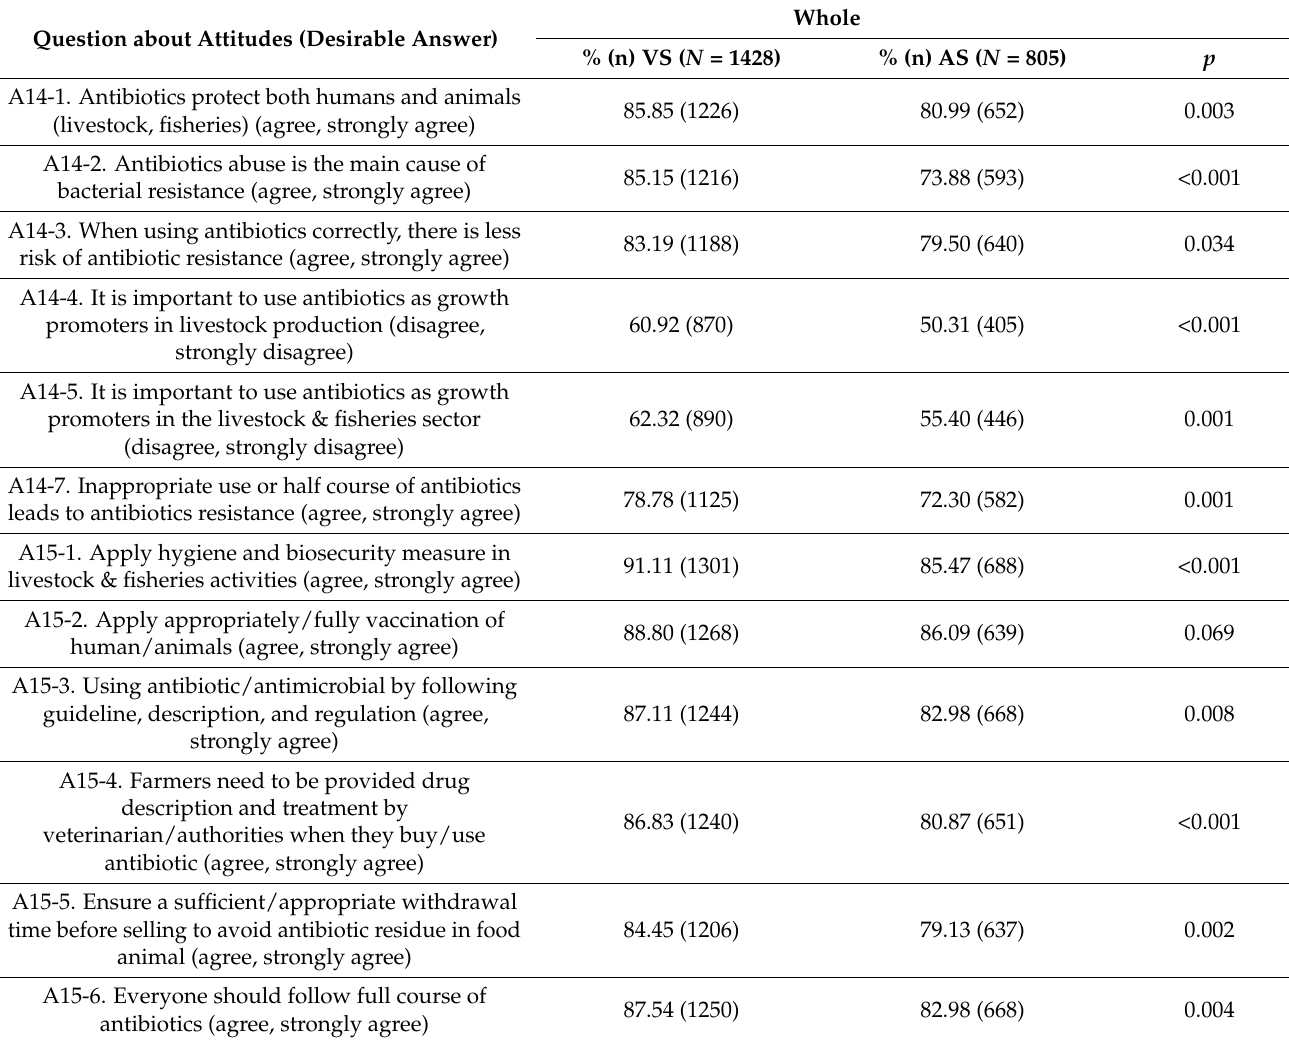
Table A2. Proportion of responses to questions about attitudes in veterinary and agriculture